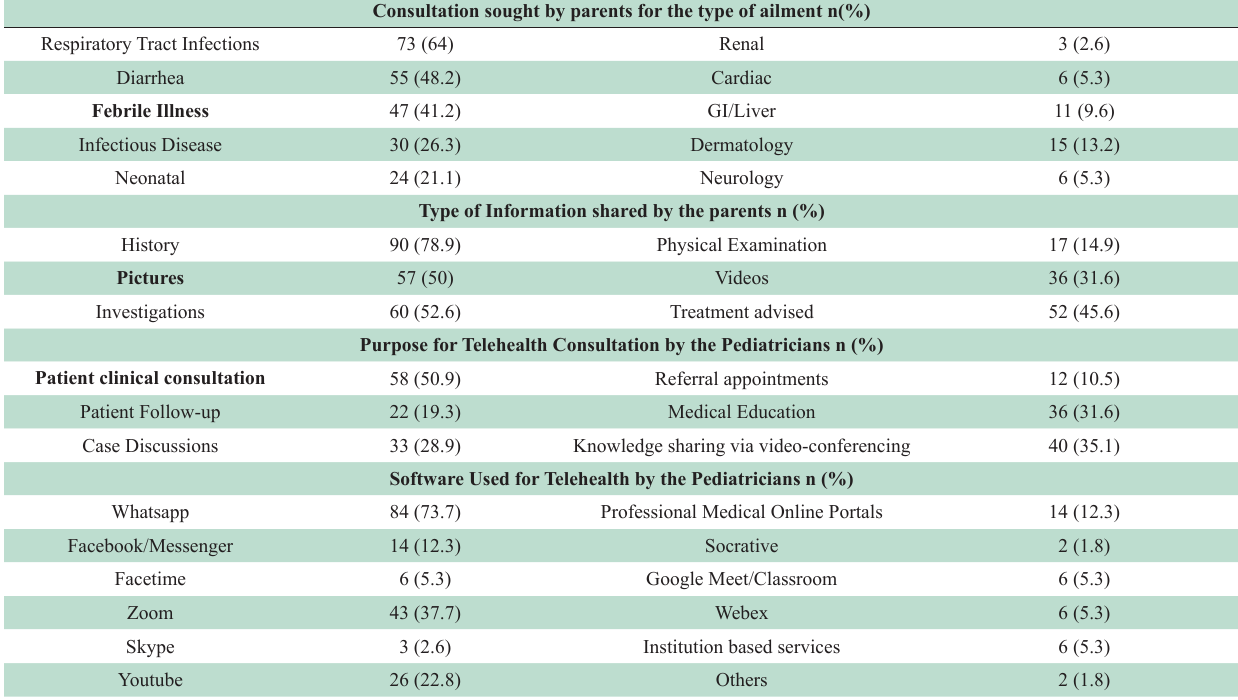
Table-III: Details of the telehealth consultations provided by the pediatricians (n=114).